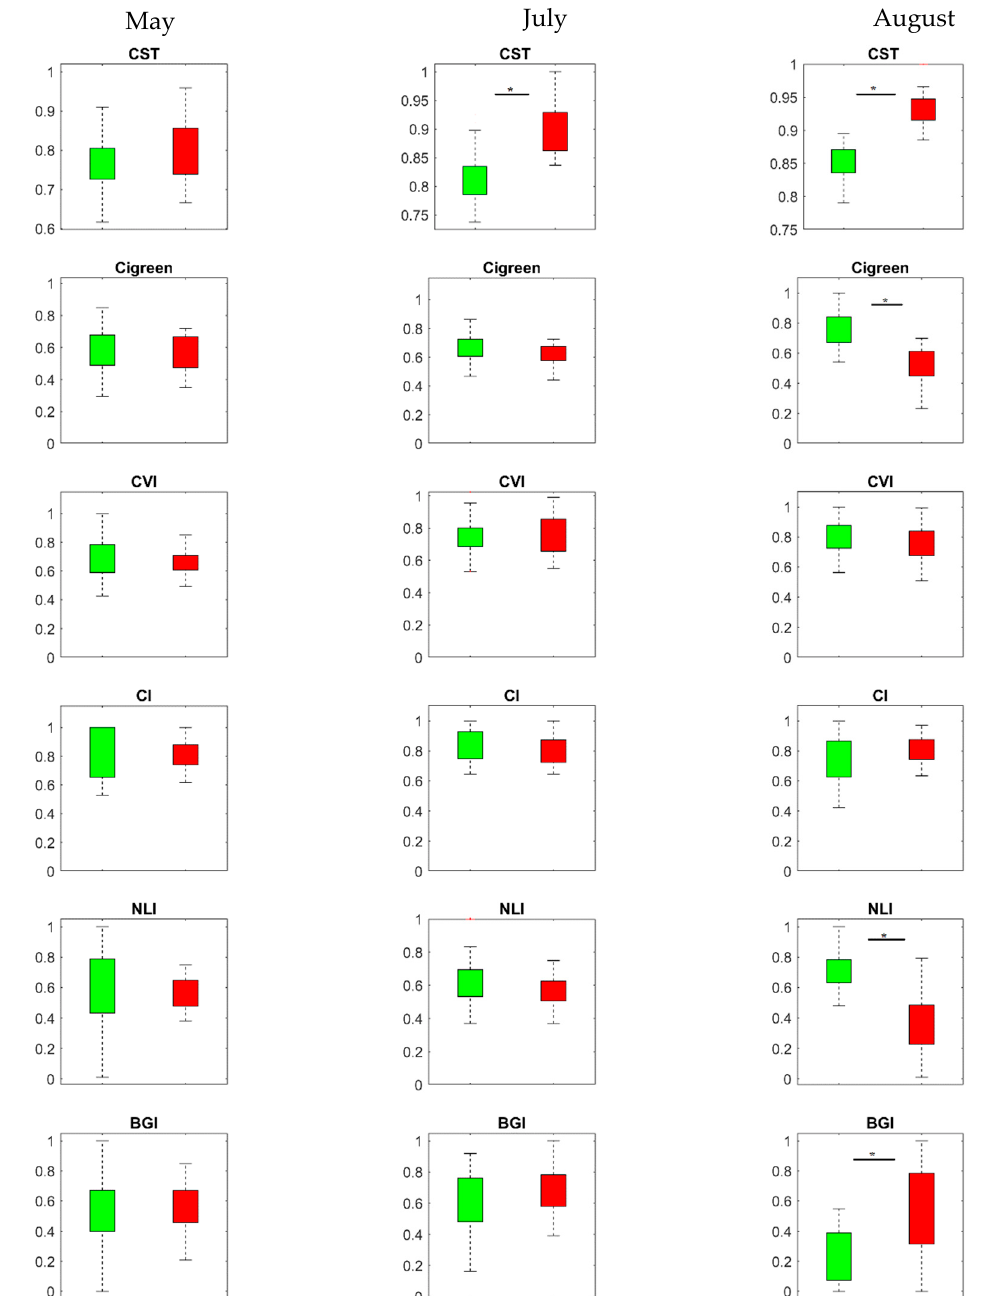
Figure 6. Temporal variation of the SVIs and CST (VIP > 1) for healthy and green attacked sample plots in the Bavarian Forest National Park. Green and red boxes represent healthy and infested plots, respectively. A * indicates the significant difference between healthy and infested plots obtained using Student’s t tests.